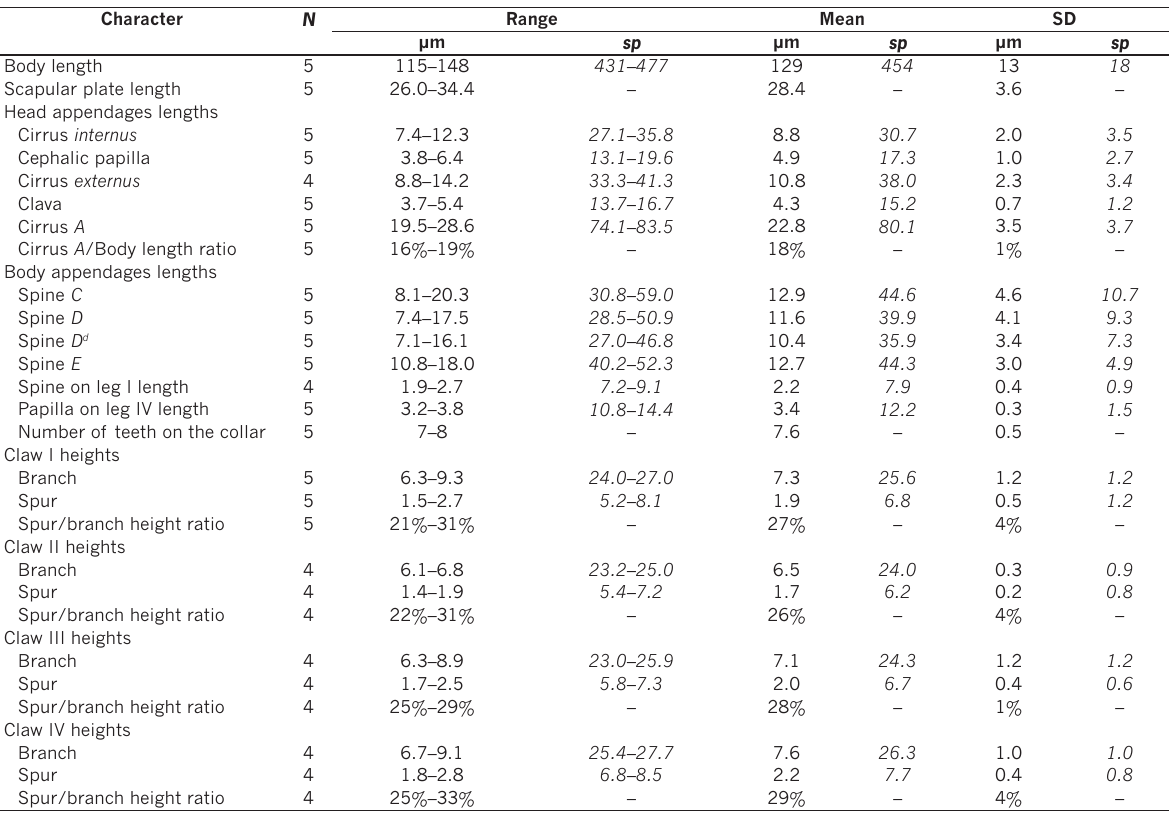
Table 5. Measurements [in µm] of selected morphological structures of the juveniles of Echiniscus masculinus sp. nov. mounted in Hoyer’s medium. N – number of specimens/structures measured, RANGE refers to the smallest and the largest structure among all measured specimens; SD – standard deviation; sp – the proportion between the length of a given structure and the length of the scapular